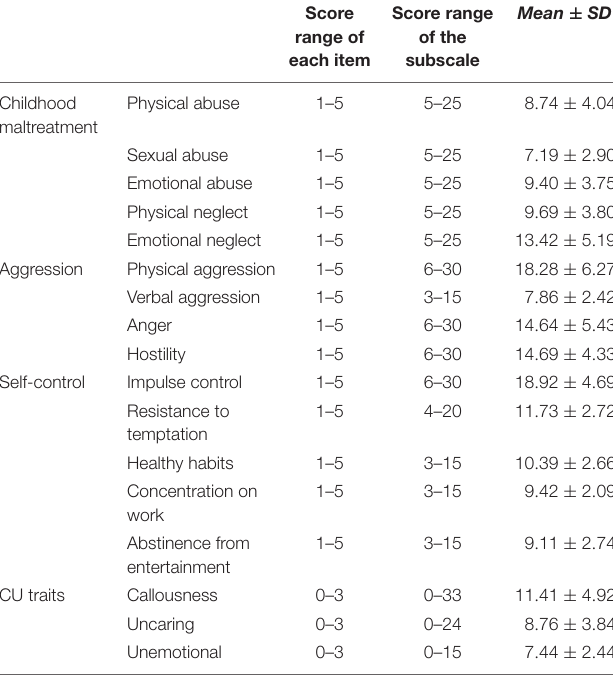
TABLE 1 | Descriptive statistics according to each